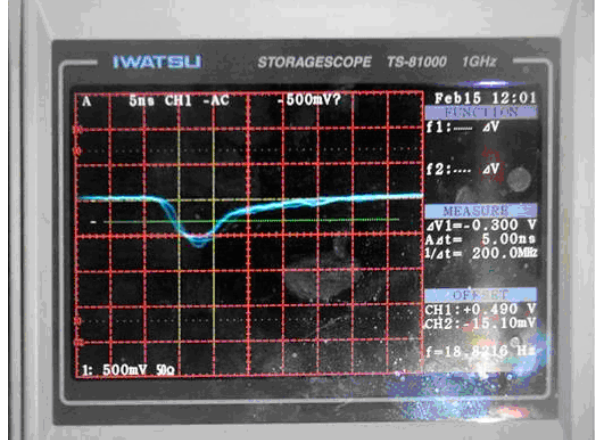
Fig. 5. Pulse output from the CW-PMT after 38 days have elapsed in the drainage tunnel.